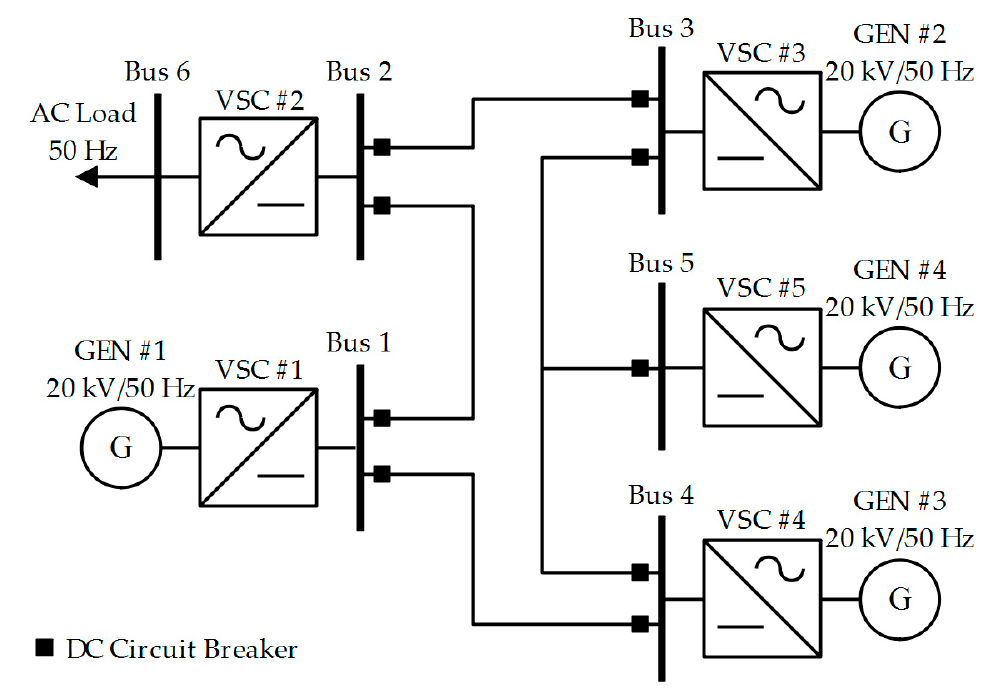
Figure 8. The configuration of the studied five-terminal MT-HVDC system.